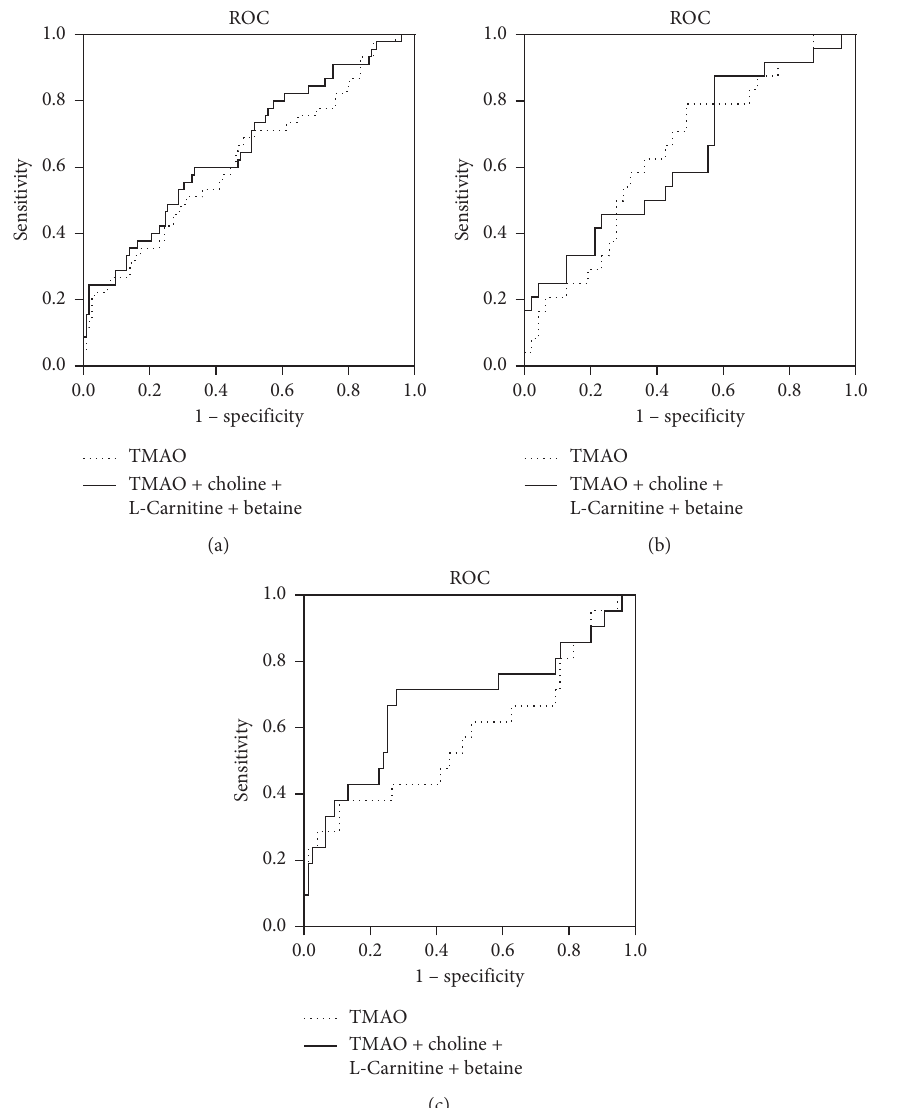
Figure 4: ROC curves of betaine, choline, L-carnitine, and TMAO for discriminating severe artery stenosis from mild artery stenosis in all, male, and female participants. AUC indicates area under the receiver-operating characteristic curve. (a) All; (b) male; (c) Table 4: AUC of TMAO, choline, L-carnitine, and betaine for predicting CAD in all, male, and female participants. AUC 95% CI p All TMAO